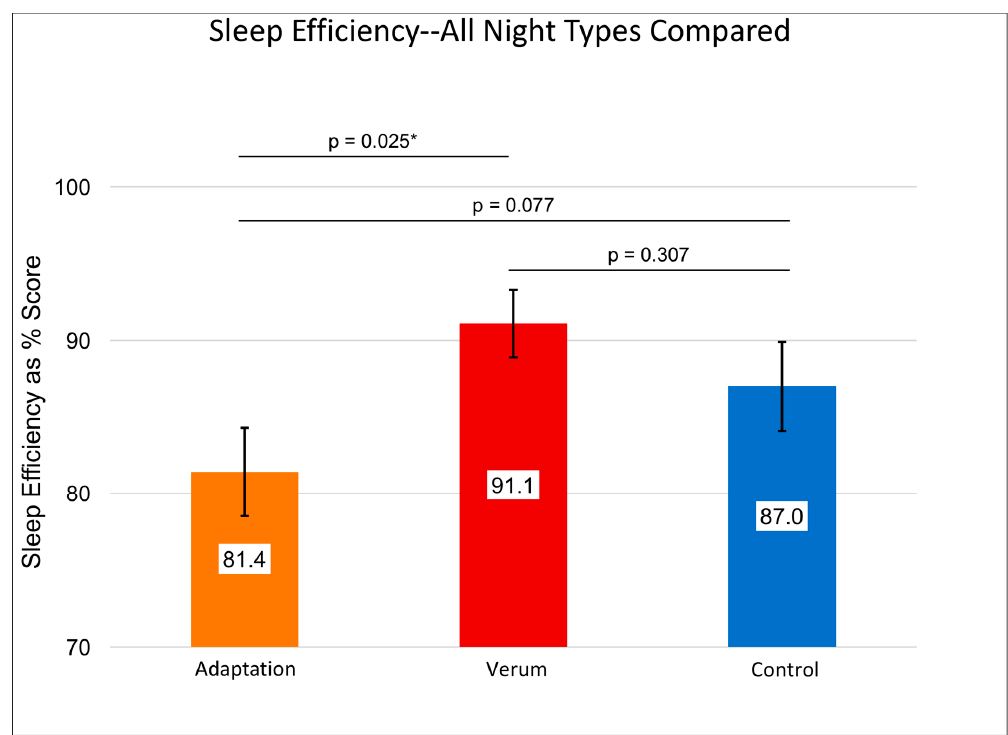
Figure 2. Shows the repeated measures effects adaptation night 1 (orange) and verum (red bar) vs. control (blue bar) stimulation collapsed across nights 2 and 3 on sleep efficiency, n = 14. Results of individual, uncorrected t-tests are shown at the top. An asterisk “*” indicates a significant difference ( p < 0.05). The omnibus within-subjects’ F was significant at p = 0.038. Error bars represent +/- 1 standard error of the mean. Sleep efficiency variables only exist for nights of in-laboratory sleep, so no “Pre-Lab Sleep” measure could be obtained. Sleep efficiency for verum night was significantly greater than that for the adaptation